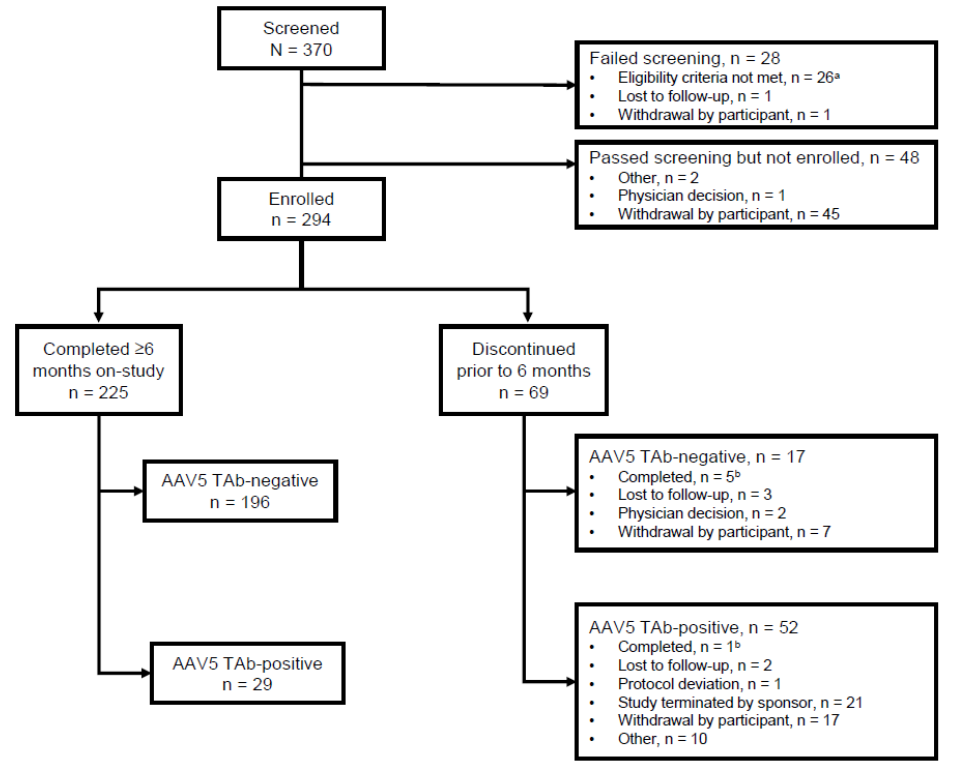
Figure 1. Patient disposition. a Reasons for screen failure: no history of FVIII inhibitor and results from a Bethesda assay, n = 8; significant liver dysfunction with abnormal laboratory results, n = 3; active hepatitis C, n = 6; chronic or active hepatitis B, n = 1; concurrent enrolment in another clinical study, n = 2; ability to comply with protocol requirements per Investigator, n = 2; male ≥ 18 years of age with residual FVIII ≤ 1, n = 1; must have been on prophylaxis FVIII for ≥ 6 months prior, n = 4. b Completing 6 months on-study was not required for participants not rolling over into the interventional study. AAV5 TAb, adeno-associated virus vector total antibody; FVIII, factor VIII.